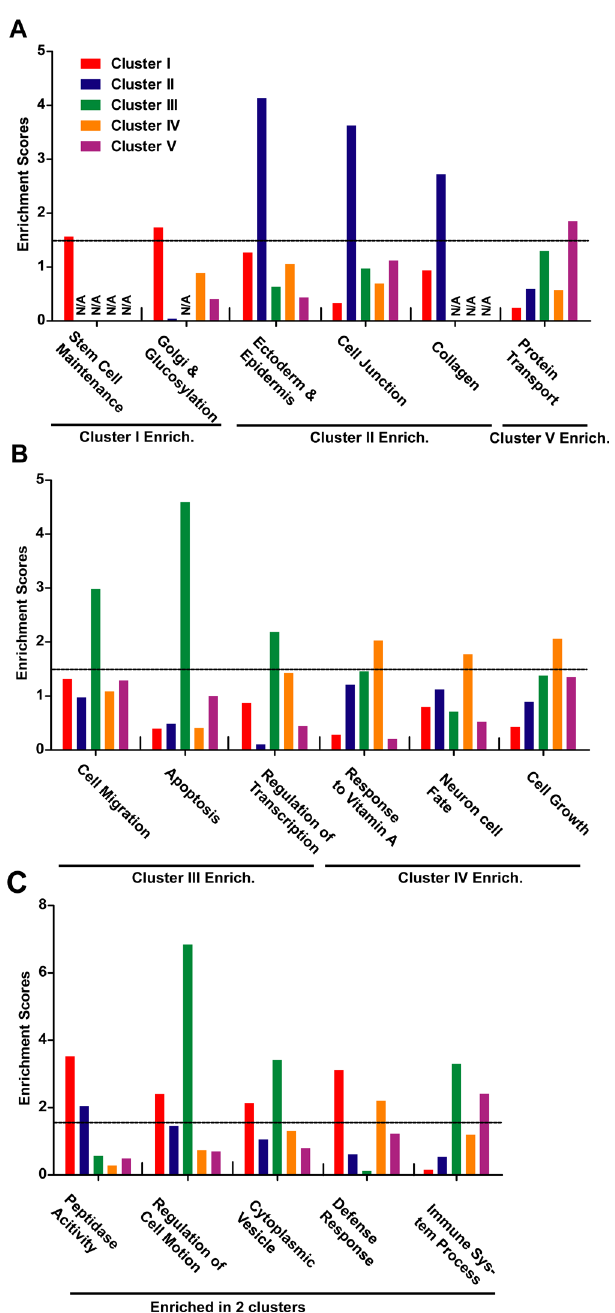
Fig 5. GO terms enriched in one or two clusters. Five clusters of human EMT-induction samples were used to identify five gene lists, which were than subjected for GO analysis. The GO terms enriched in Cluster I, II or V were listed in (A), while those enriched in Cluster III or IV were in (B). The GO terms enriched in two of the five clusters were listed in (C). The enrichment score for one group of GO terms were calculated by averaging the scores of included GO terms, which were provided by DAVID. Enrichment scores over 1.30 were considered as significantly